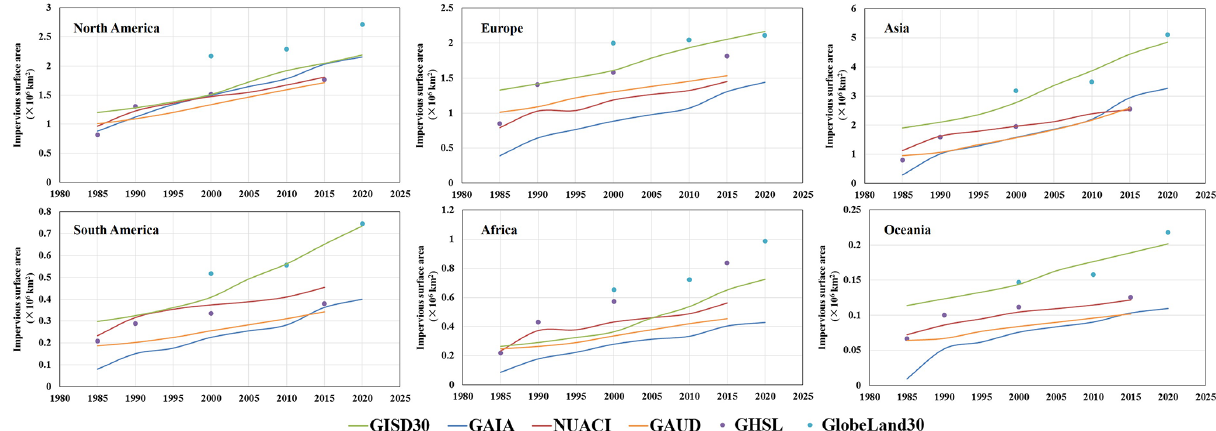
Figure 9. The impervious area of six global 30m impervious-surface products on six continents over the period of